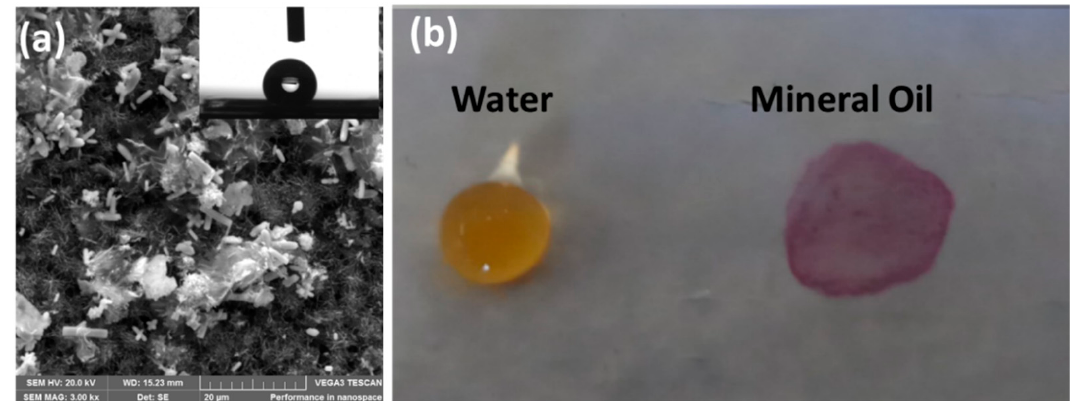
Figure 10. ( a ) SEM image of ZnO rods stearic-acid-modified PES membrane. Inset is corresponding water contact angle image. ( b ) Superhydrophobic and superoleophilic nature of corresponding membrane. Reprinted from [61]. Copyright (2020) with permission from Elsevier.